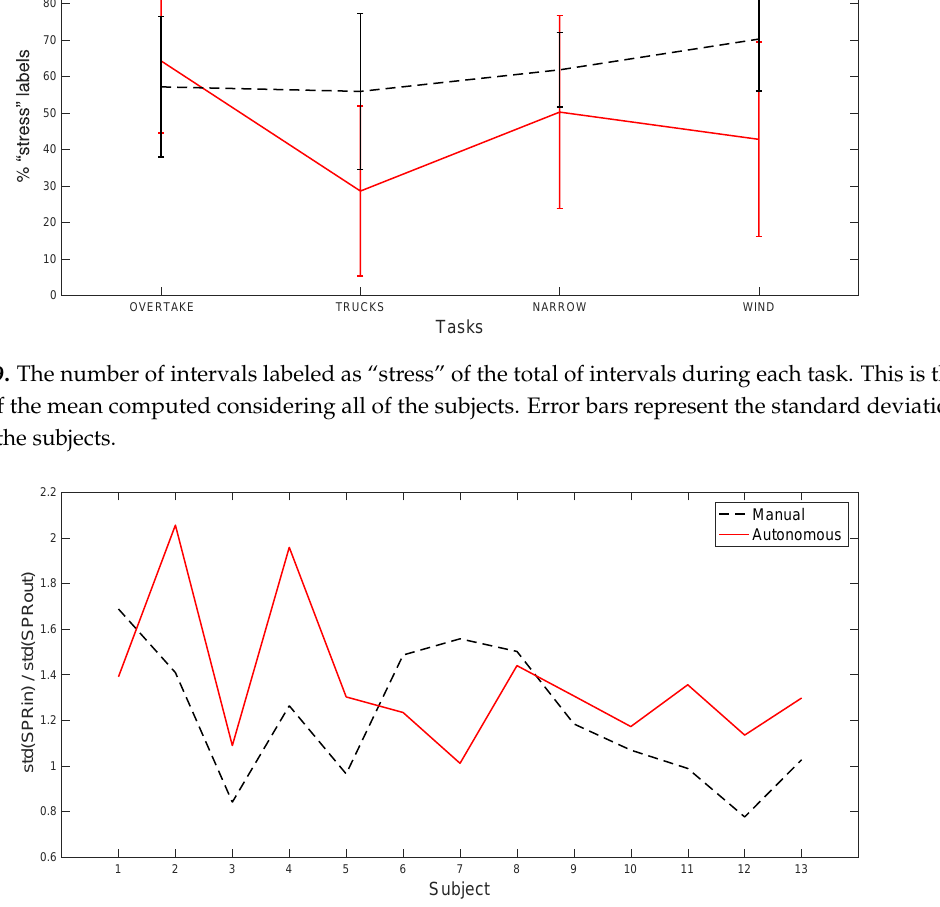
Figure 10. The ratio between the standard deviation of the SPR during the tasks and outside the tasks, in the manual and autonomous